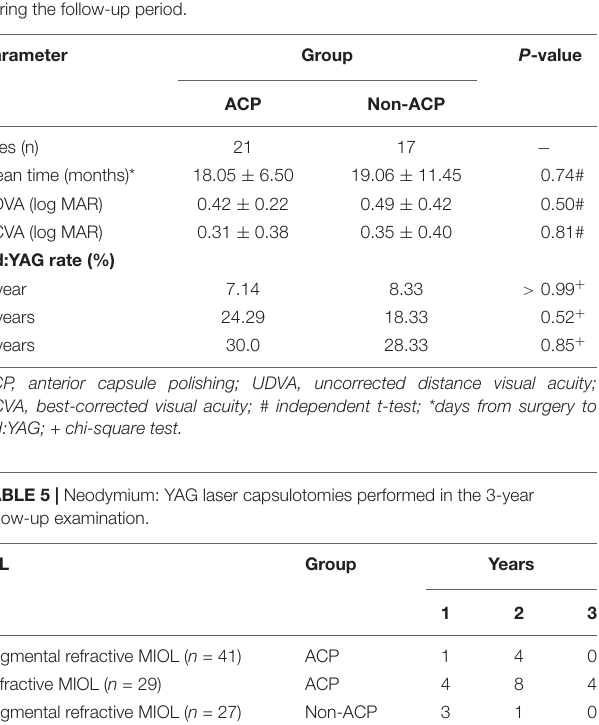
TABLE 4 | Characteristics of patients who underwent of Nd: YAG capsulotomy during the follow-up period.